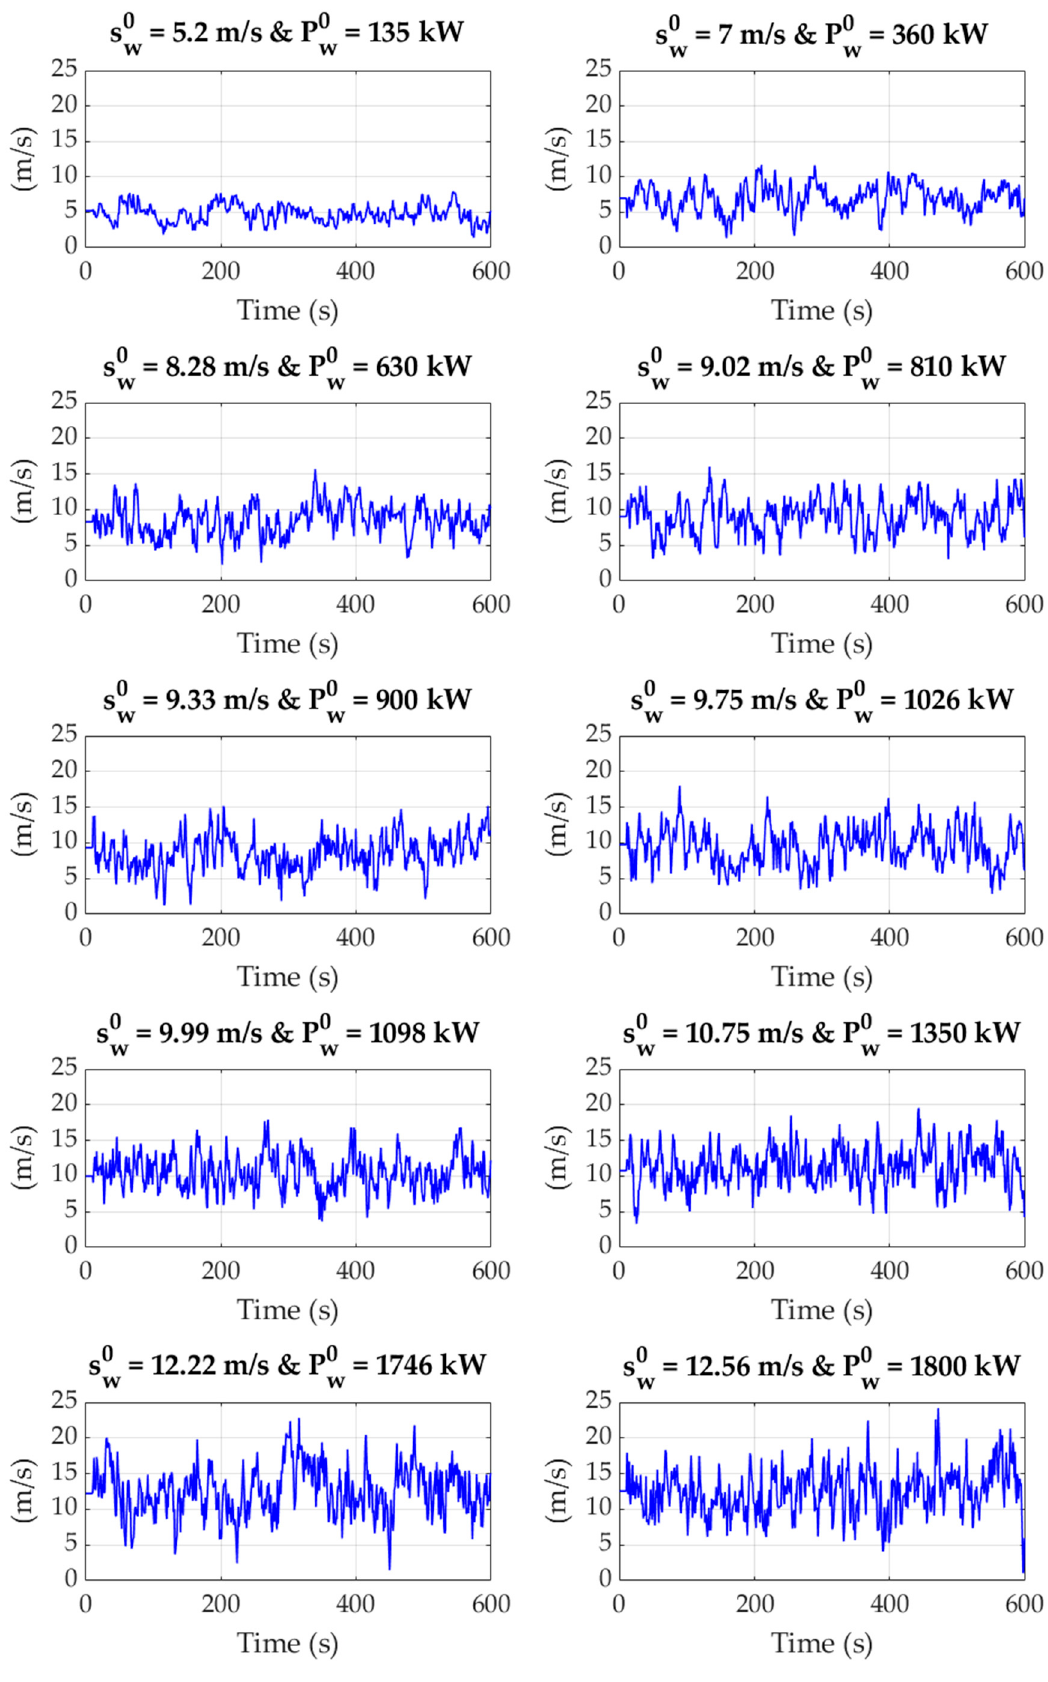
Figure A1. Ten generated wind speed signals.